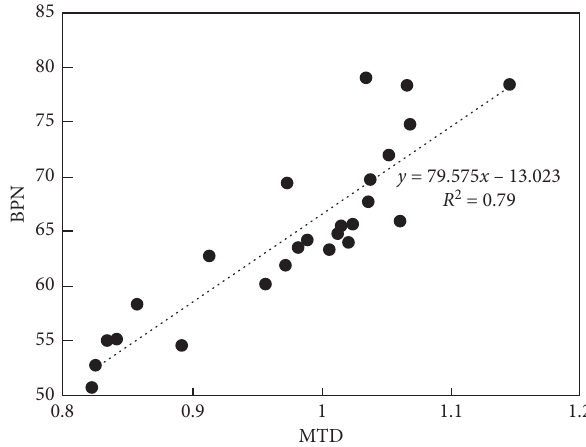
Figure 11: Correlation between MTD and